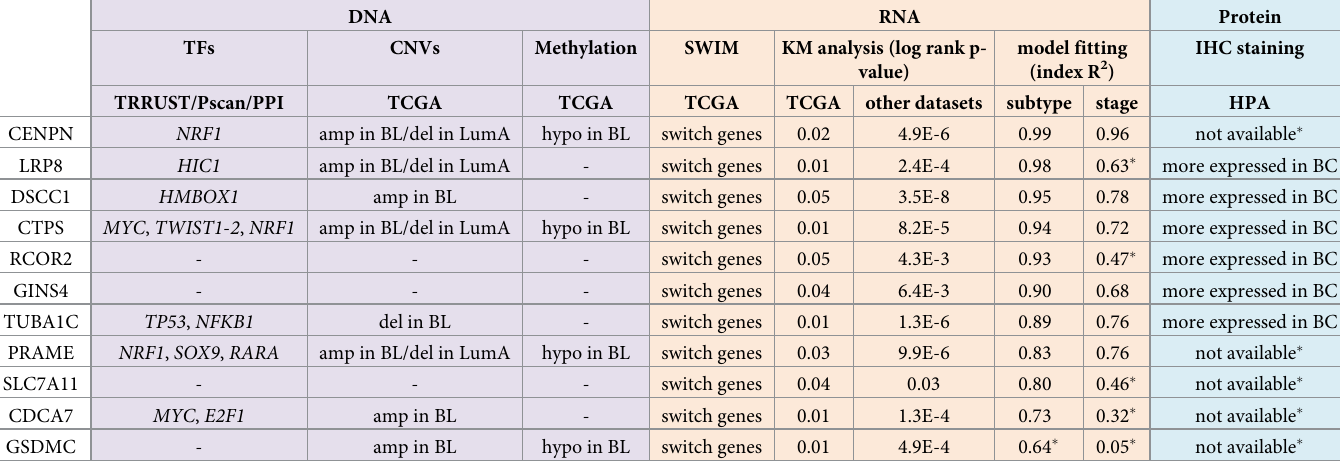
Table 1. Summary of the properties of the basal-like prognostic biomarkers.